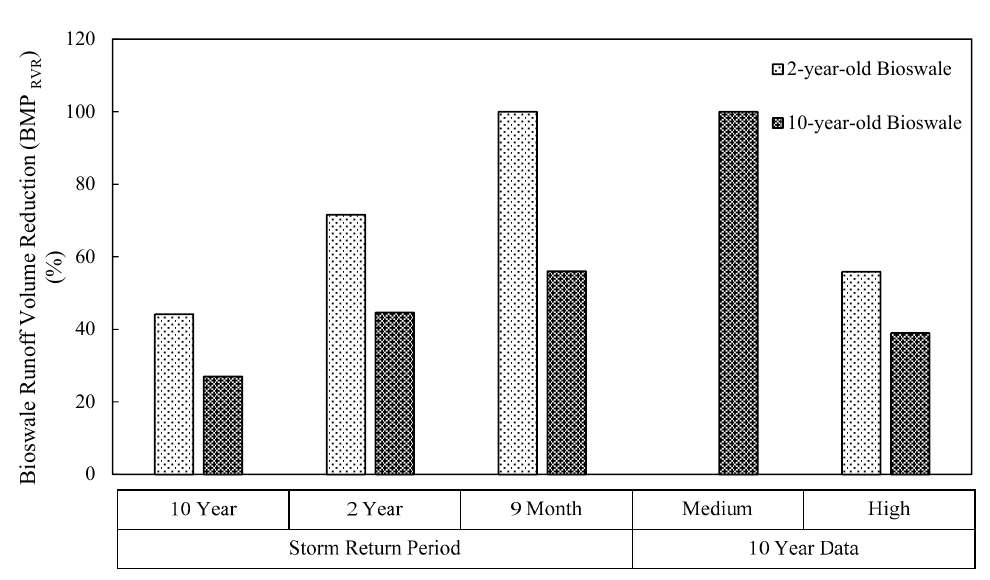
Figure 7. BMP RVR of different cells on different rainfall scenarios.